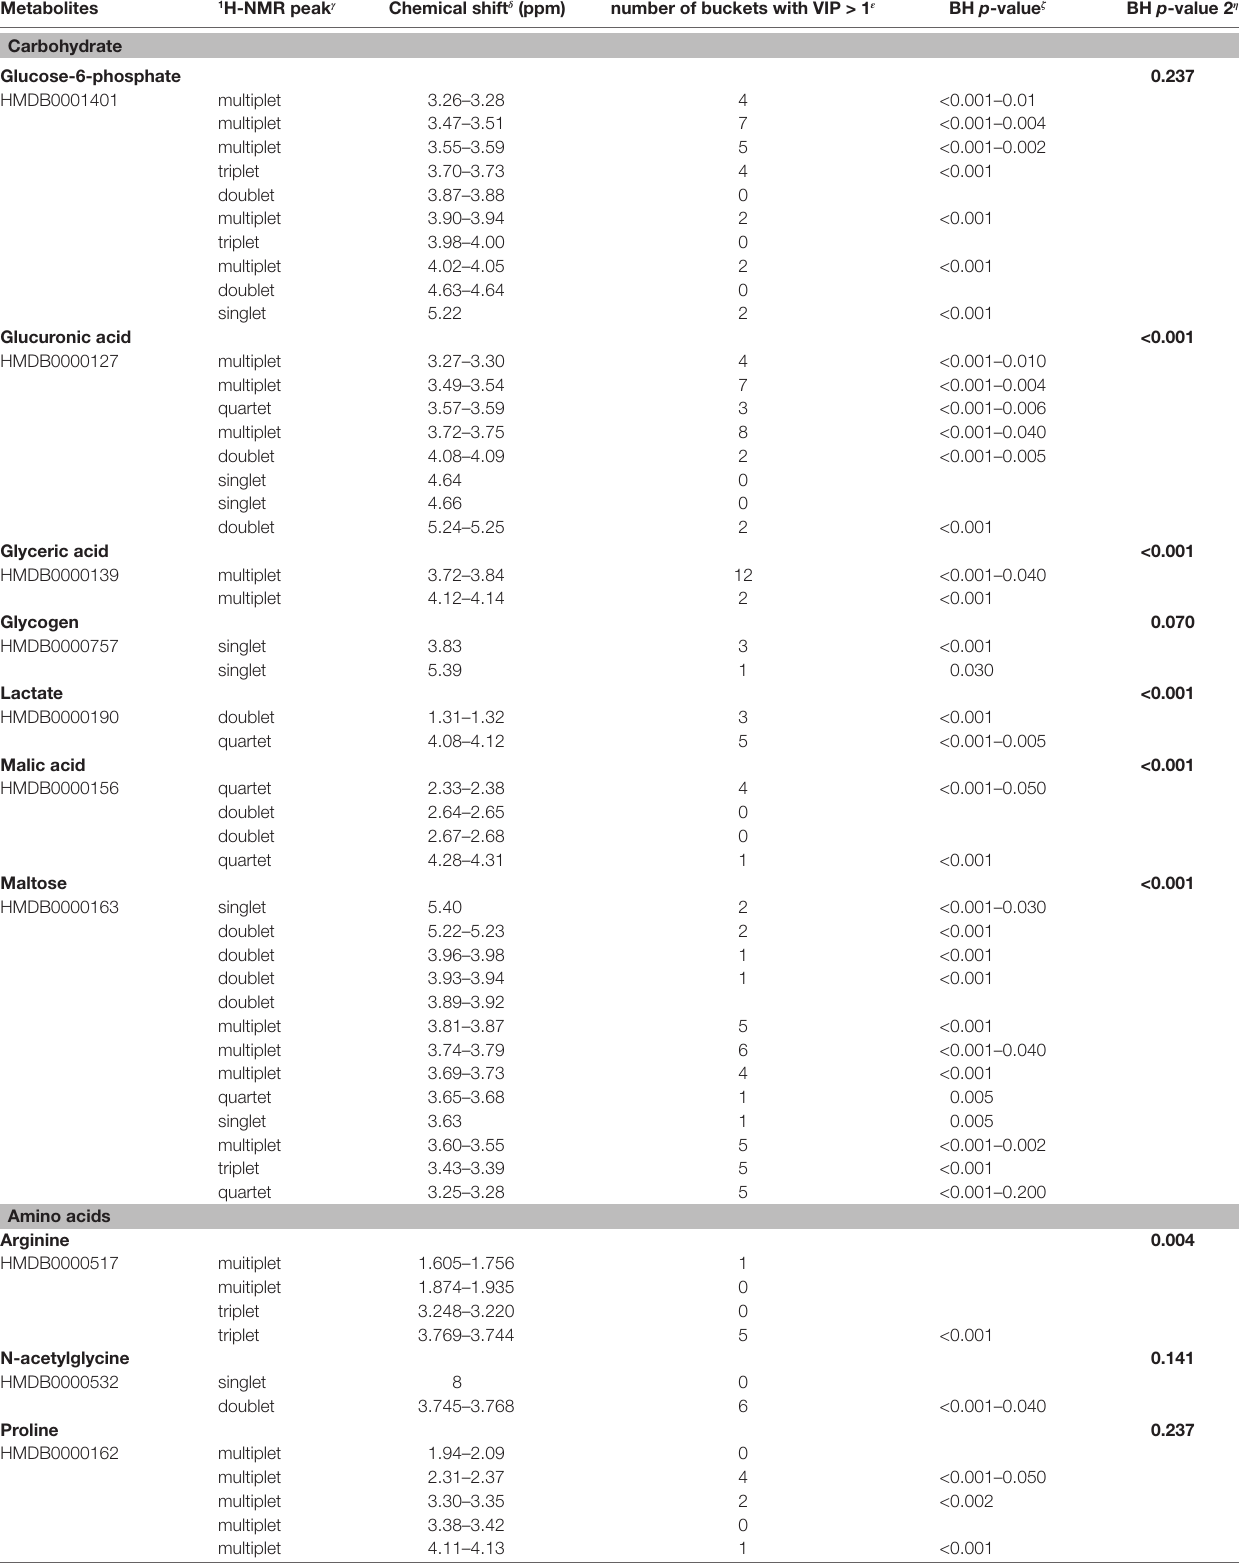
TABLE 1 | List of the 14 biomarkers of foie gras liver weight identified with the bucket method.